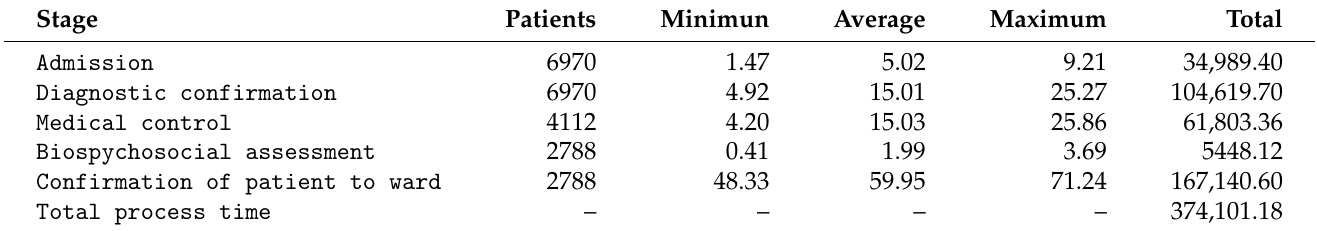
Table 3. Prioritization of patients in SWL according to SA in the ENT unit, HCH (in